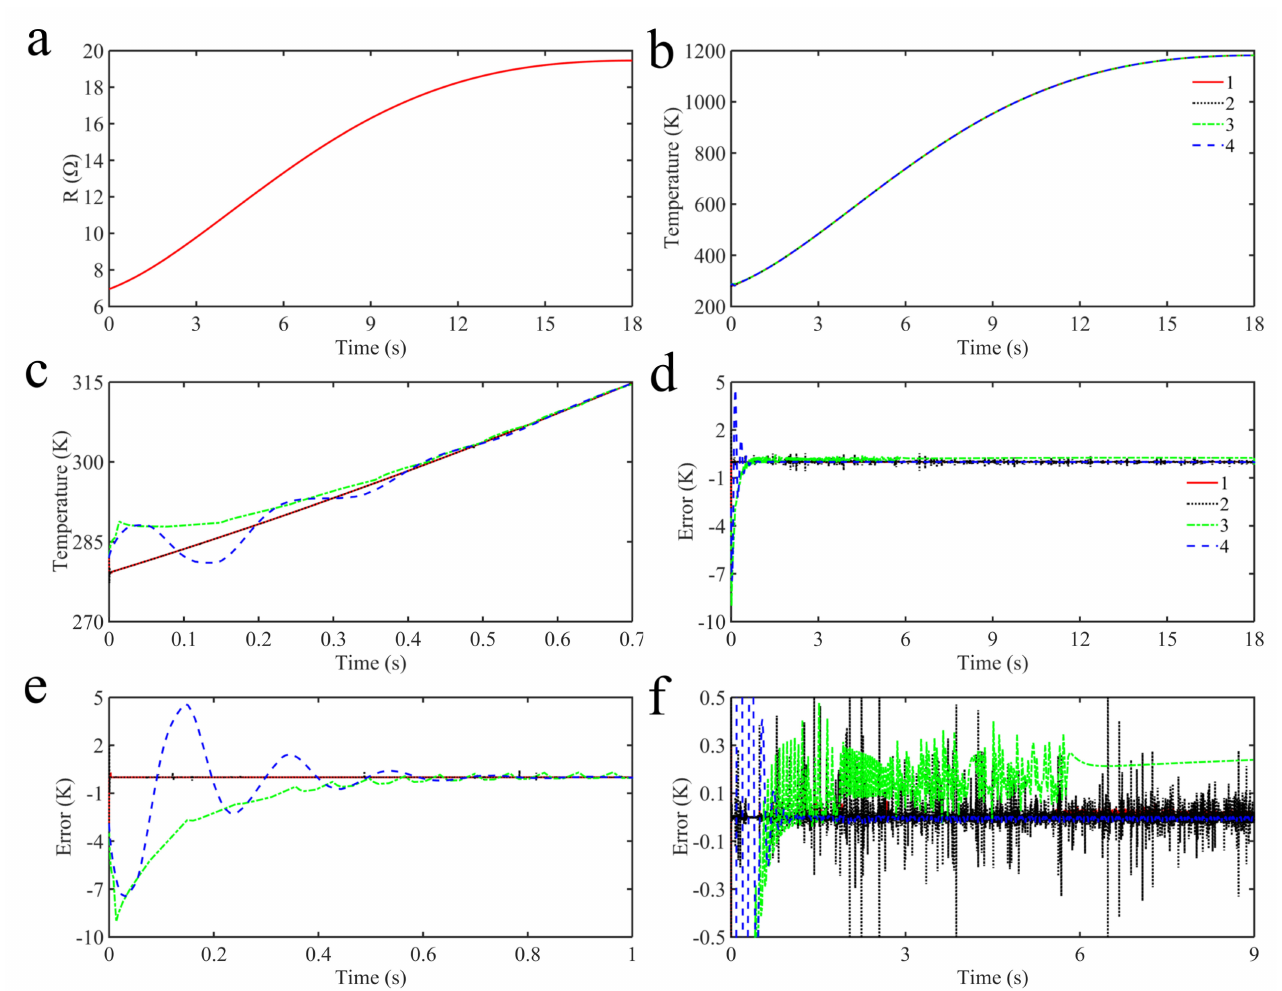
Figure 6. Simulation results with ( a ) extra disturbances: ( b ) tracking temperature trajectory; ( c ) partial enlarged drawing of tracking temperature trajectory; ( d ) tracking errors; ( e , f ) partial enlarged drawings of tracking errors among (1) STNFOSMCTDE, (2) LFOSMC, (3) IPID and (4)